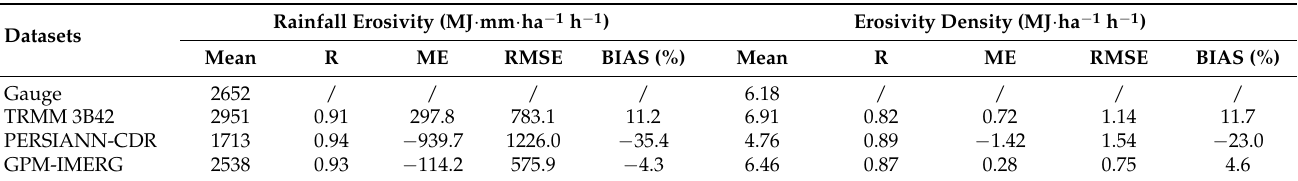
Table 2. Performance comparison of the three SPPs for rainfall erosivity and erosivity density on the seasonal scale.